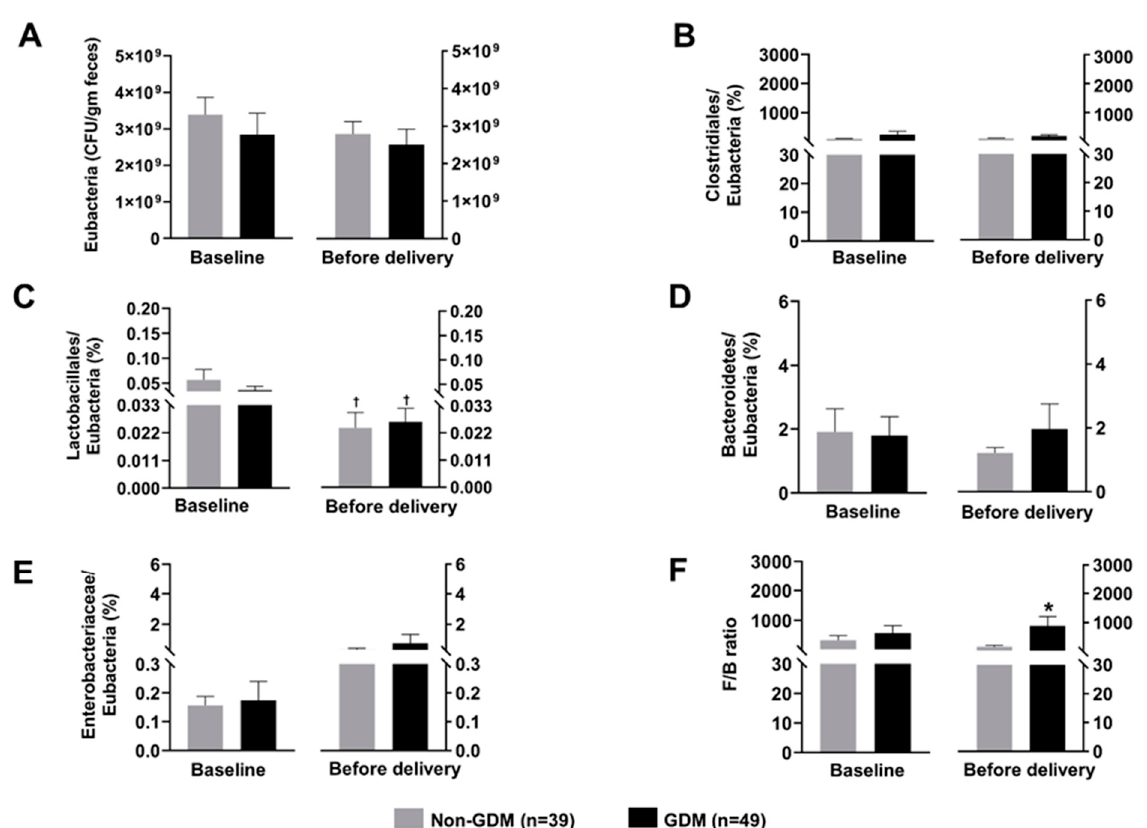
Figure 1. Composition of maternal gut microbiota at baseline (time of GDM diagnosis) and before delivery; ( A ): Total count of Eubacteria , ( B ): Normalized abundance of Clostridiales , ( C ): Normalized abundance of Lactobacillales , ( D ): Normalized abundance of Bacteroidetes , ( E ): Normalized abundance of Enterobacteriaceae , ( F ): F/B ratio. Data are reported as mean ± SEM. The Mann–Whitney U test was used to determine the difference between groups. * p < 0.05 vs. non-GDM group, † p < 0.05 vs. the same group at the baseline GDM: Gestational diabetes mellitus; F/B ratio: Firmicutes/Bacteroidetes